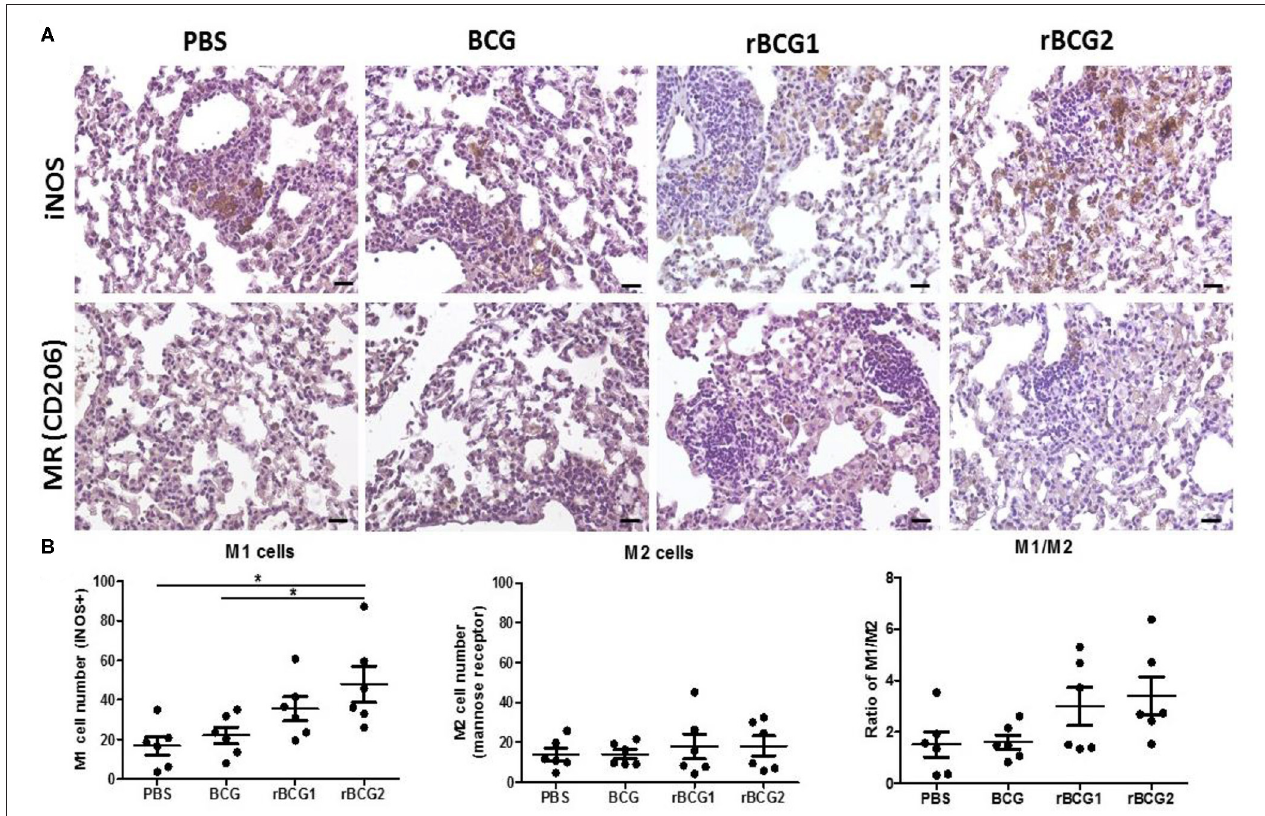
FIGURE 7 | Increased M1-polarized macrophage cells in lung tissue sections from mice vaccinated with rBCG1 or rBCG2. C57BL/6 mice were immunized with BCG, rBCG1, or rBCG2 at weeks 0 and 2, and then challenged with H37Ra at week 4 ( n = 6–7). At week 8, the mice were sacrificed. One lung from each mouse was homogenized and the other lung was fixed in 3.7% formaldehyde. (A) After fixation, lung samples were embedded in paraffin, sectioned, and stained for iNOS (M1 marker) and MR (M2 marker); scale bar = 20 µ m. The images are representative of slides from the four groups. (B) Lung tissue from six or seven animals per group was examined, and the number of DAB + plus hematoxylin-positive cells for each slide, based on five or six random views (each field of view has an area of 8.4 × 10 3 µ m 2 ), was calculated. Differences among groups were determined by one-way ANOVA with a Tukey post hoc test (* P < 0.05).